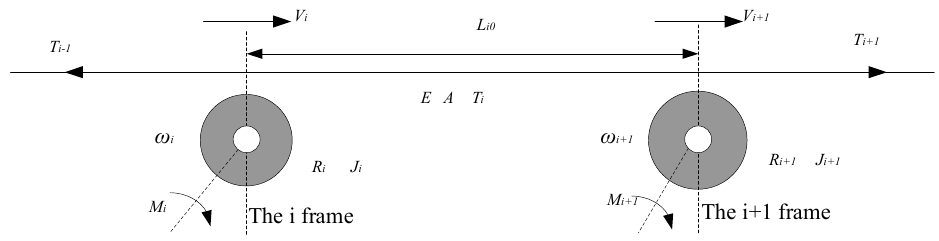
Figure 6. Sectional view of guide roller.